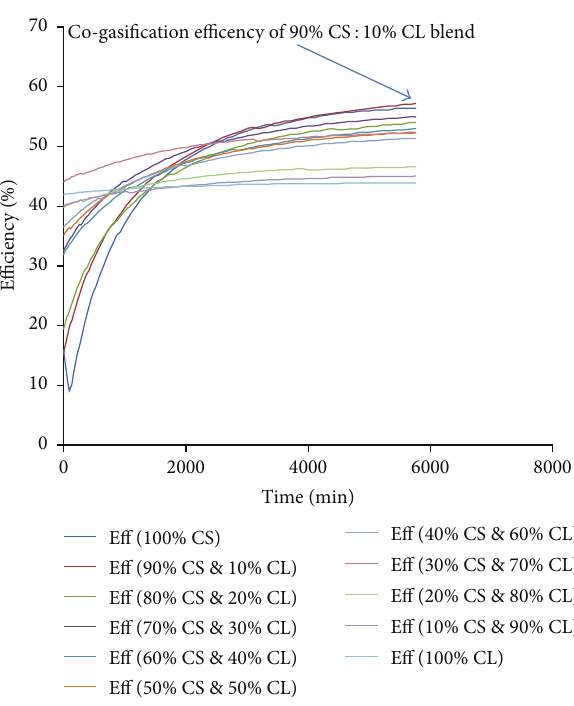
Figure7:Simulatedefficiencyofthecogasificationprocessesofpure and blended samples of corn stover and